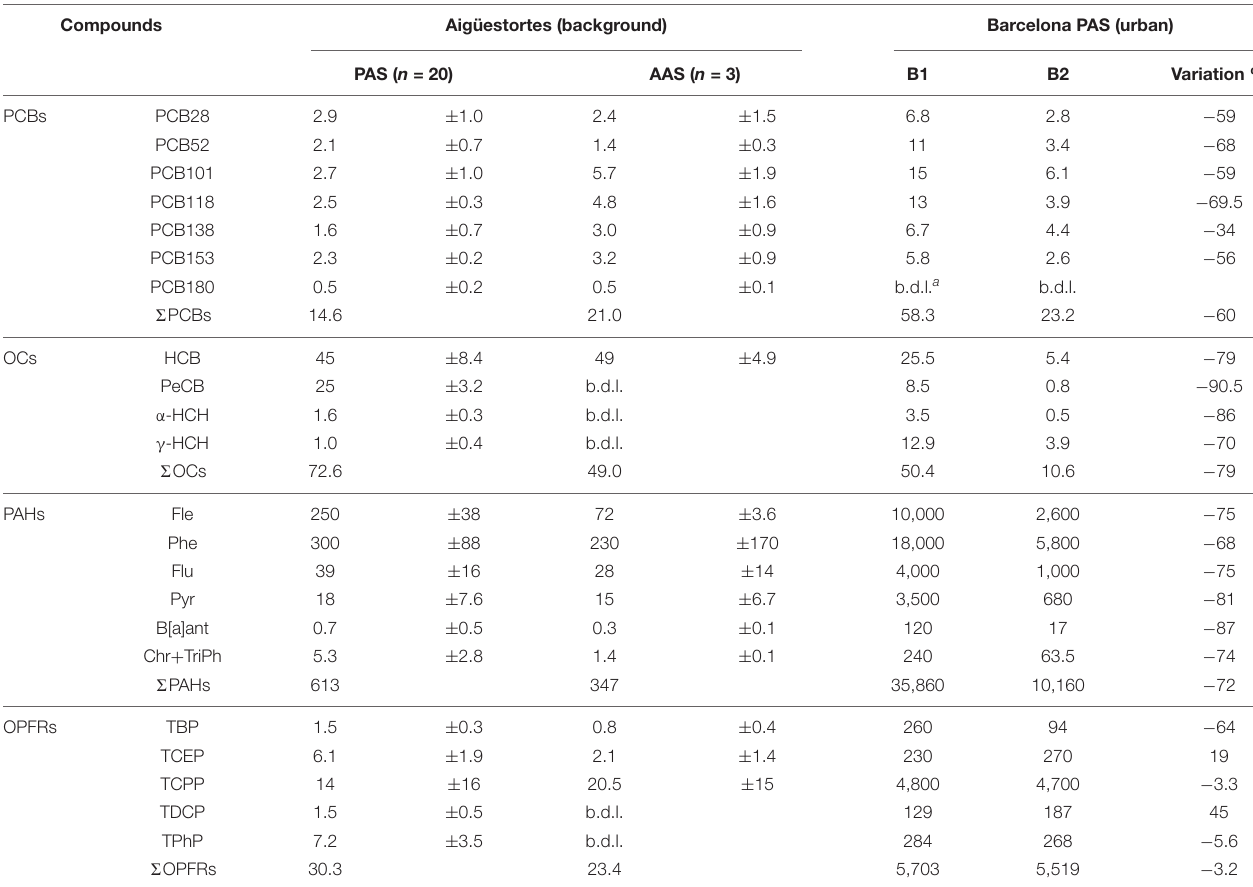
a b.d.l. Below detection